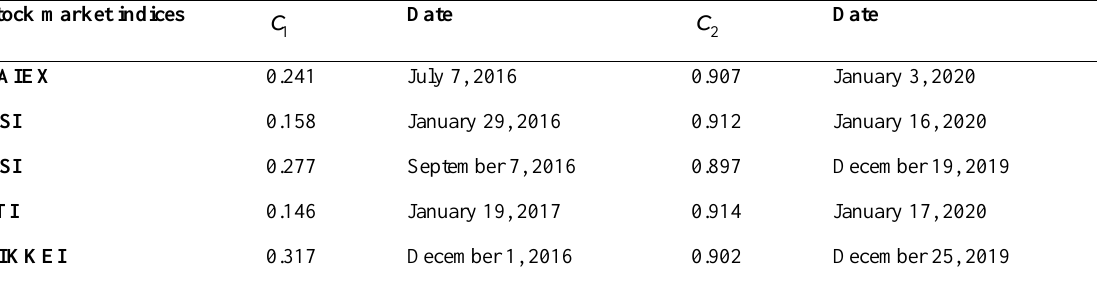
Table 7: The estimation of location parameters and corresponding calendar dates Stock market indices